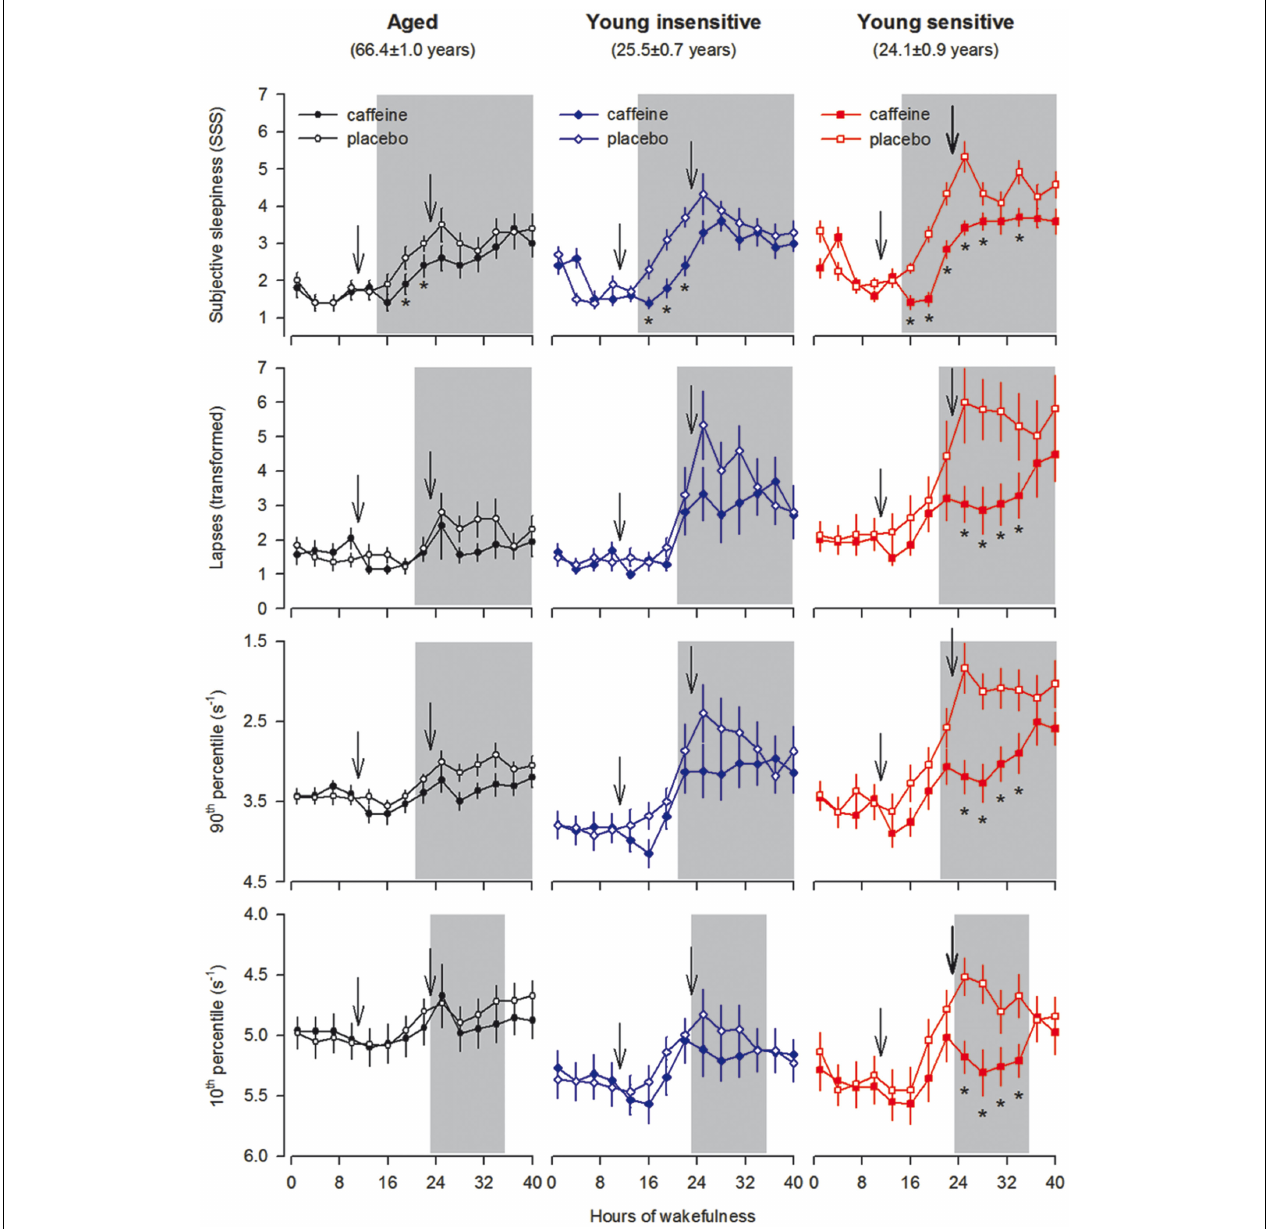
the x -axes were rounded to the previous hour. Data represent means ± SEM. Caffeine (200mg) was administered 11 and 23h into the scheduled waking period (arrows). Open symbols: placebo condition; filled symbols: caffeine condition. Gray shading indicates the test sessions, which showed a significant “ group ” × “ treatment ” interaction (see Table 1 for further details of the statistical analyses). * p < 0.05 (false discovery